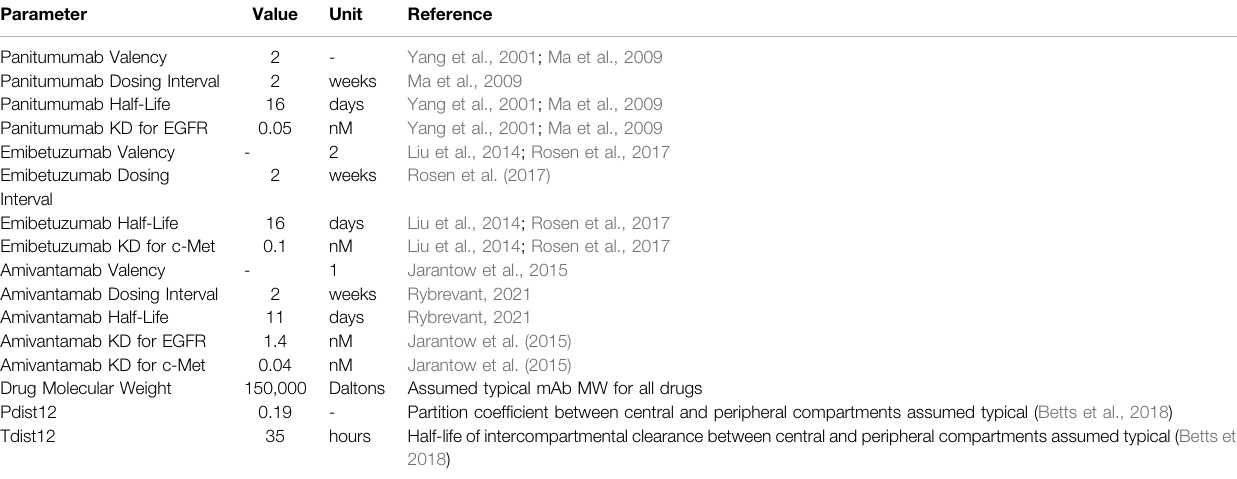
TABLE 4 | Drug speci fi c model parameters for panitumumab, emibetuzumab, amivantamab.